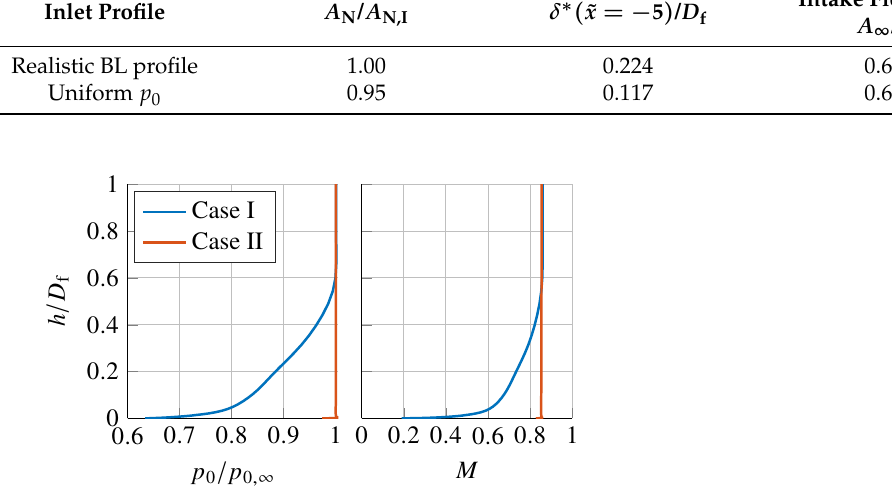
Figure 5. Profiles of stagnation pressure p 0 and Mach number M at CFD domain inlet ( ˜ x = centre